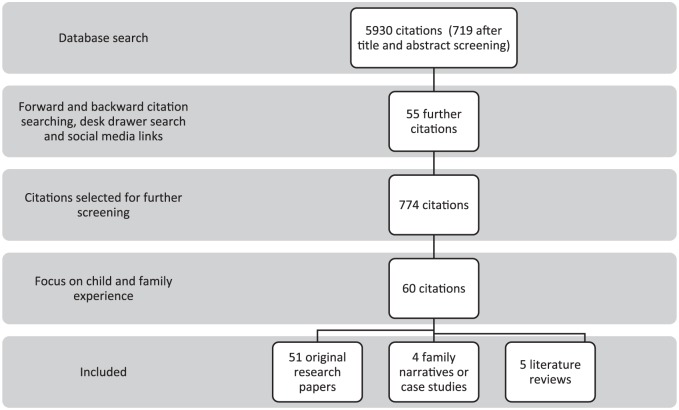
PRISMA flow diagram.